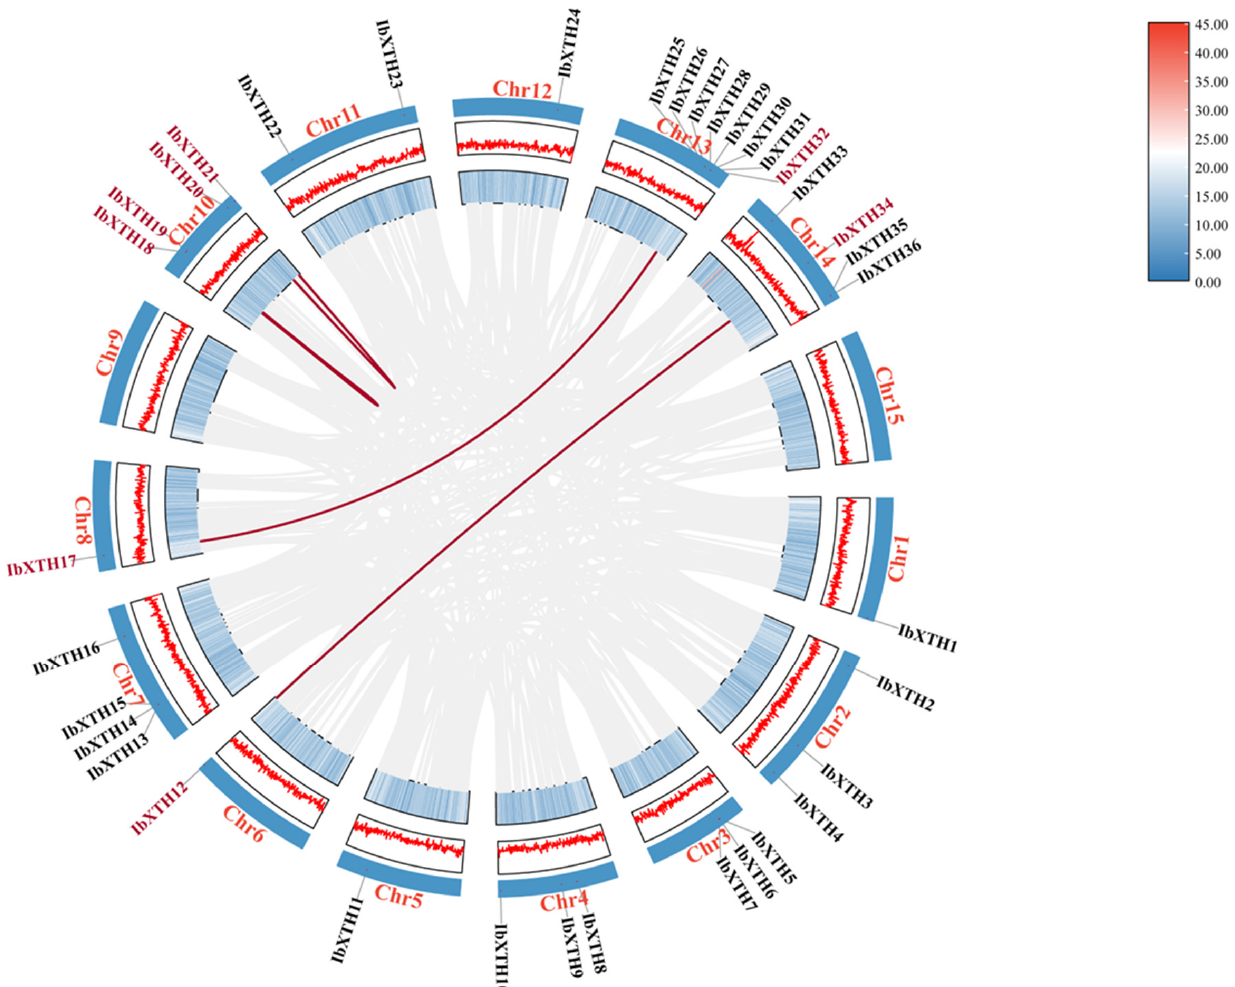
Figure 5. Fragment duplication analysis of the sweet potato XTHs. The red lines represent the fragment duplicate gene pair, and the gray lines represent the synteny blocks of the XTH genes in the sweet potato genome. The line and heat map in the outer circle represent gene density on the